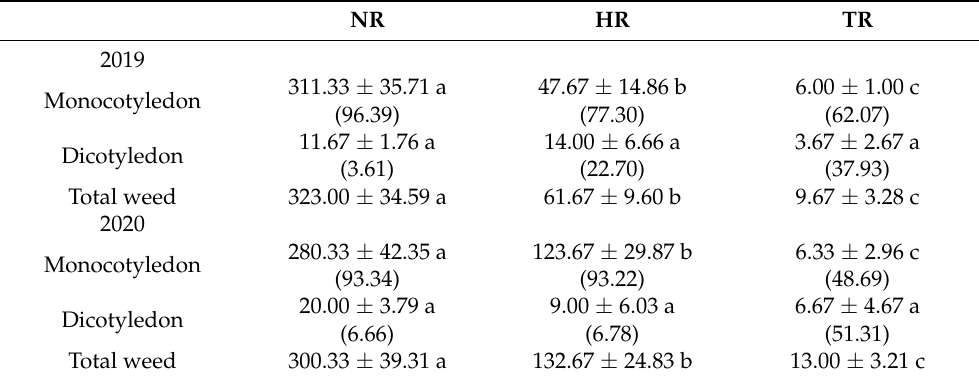
Table 1. Results of one-way analysis of variance of weed density (individuals m − 2 ) of treatments (NR, no crop residues retention; HR, half crop residues retention; TR, total crop residues retention) during the experiment period.